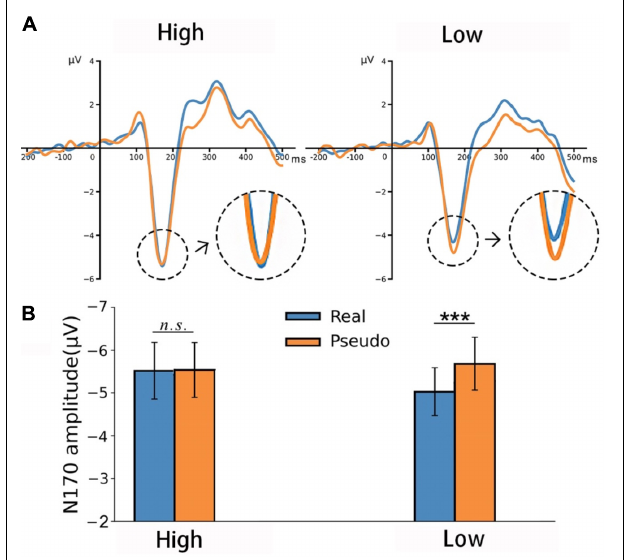
FIGURE 4 | (A) The ERP waveforms in response to real and pseudo characters in the P7 channel. (B) Bar plots comparing the N170 amplitudes for pseudo and real characters in the high and low orthographic knowledge groups in P7 channel. *** p <